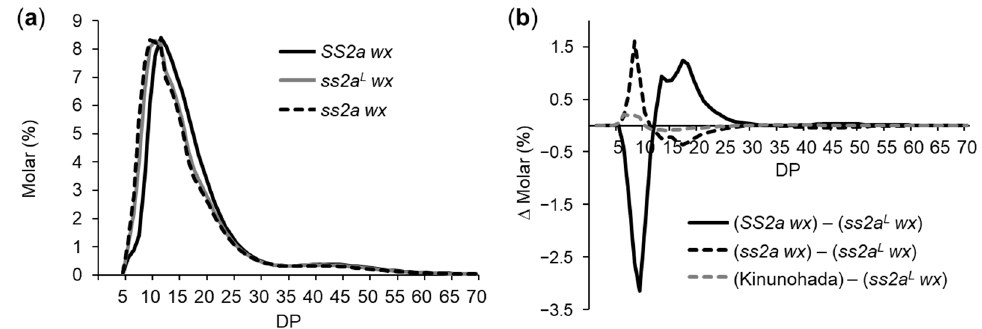
Figure 5. Analysis of amylopectin branch structure of endosperm starch by capillary electrophoresis. ( a ) Chain length distribution pattern of SS2a wx (black solid line), ss2a L wx (gray solid line), and ss2a wx (black dotted line). ( b ) Subtraction curves showing the detailed effects of SSIIa alleles on amylopectin branch structure in SS2a wx (black solid line), ss2a wx (black dotted line), and Kinunohada (gray dotted line) compared with ss2a L wx . Each panel is one typical representative dataset of at least three replicates.